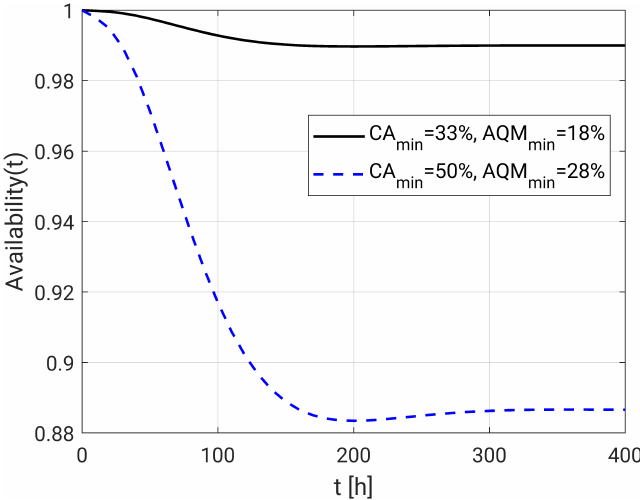
Figure 13. Availability at minimum and maximum acceptable visual